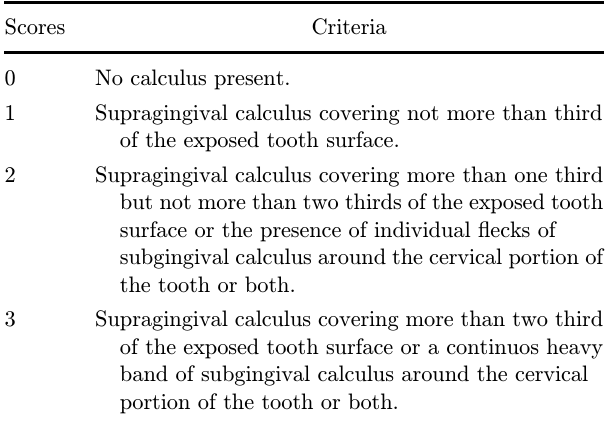
Table 2. Criteria for classifying